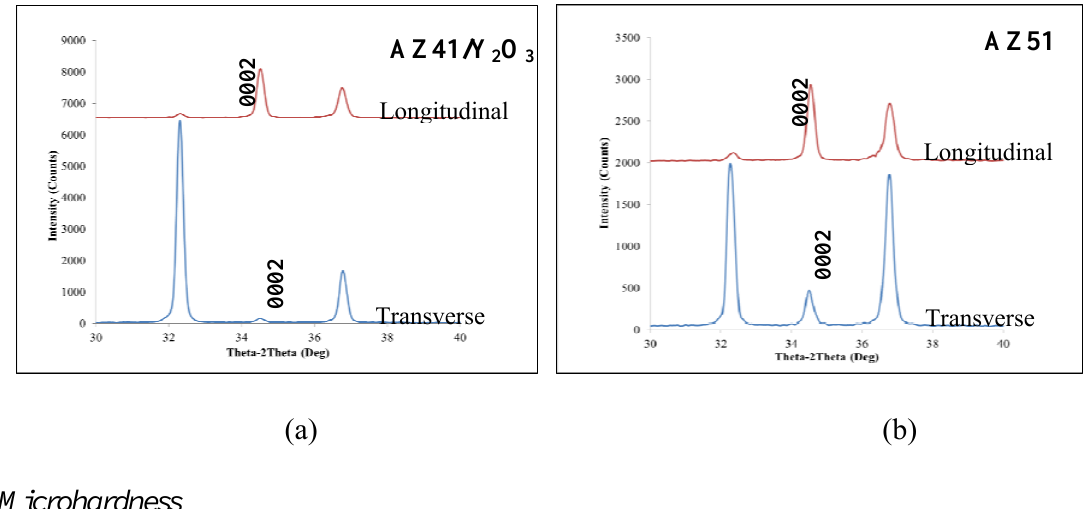
Figure 4. X-ray diffractograms showing basal (0002) plane distribution in: ( a ) AZ41/Y ( b )